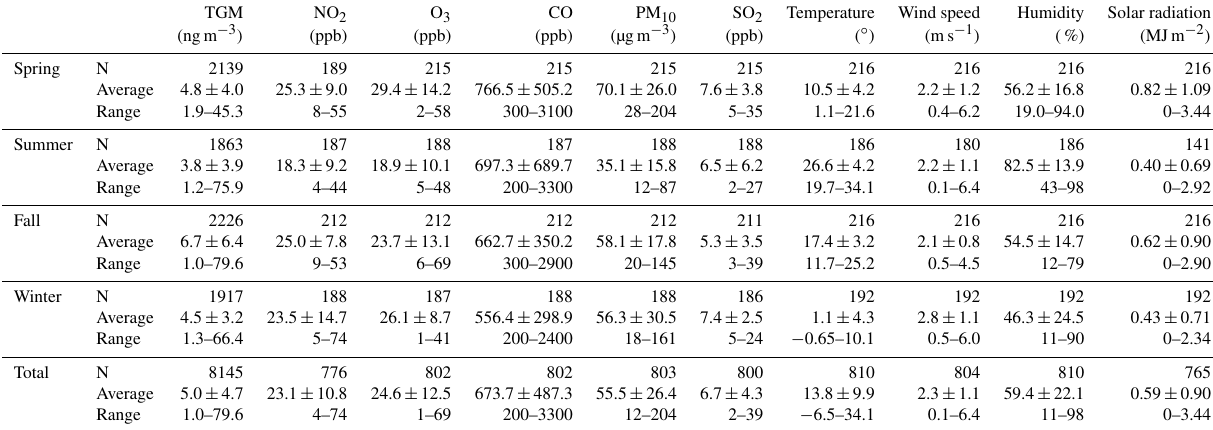
Table 2. Summary of atmospheric concentrations of TGM and co-pollutants, and meteorological data. Note that TGM was measured every 5min, and other pollutants and meteorological data were measured every 1h.